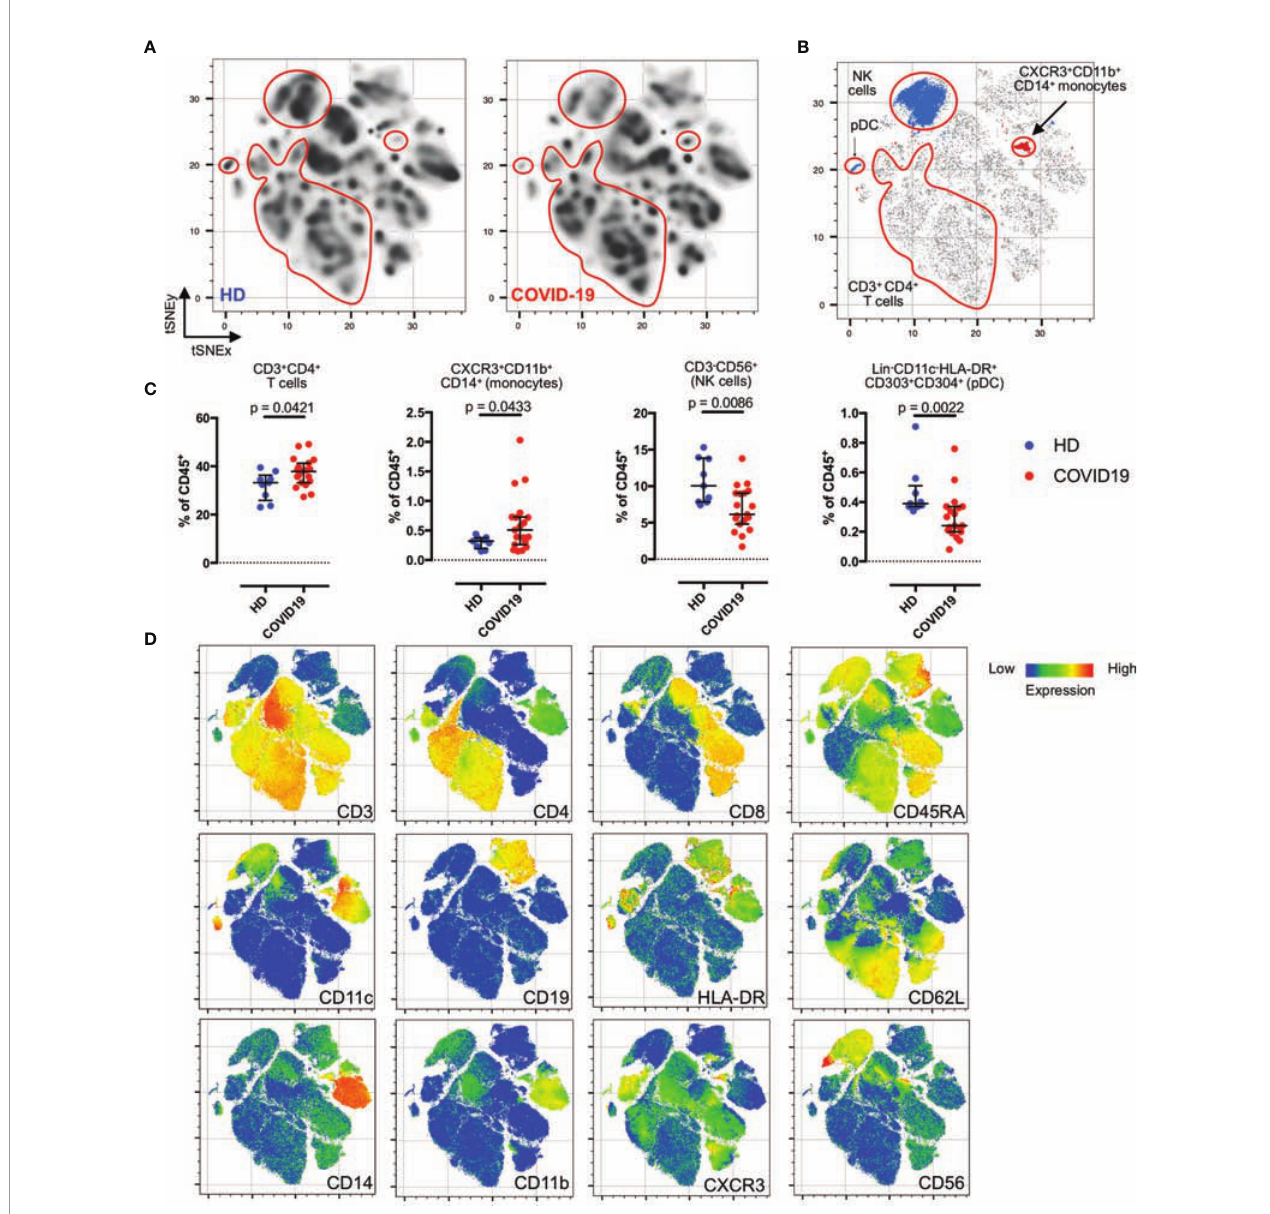
FIGURE 1 | Residual post-COVID-19 immune signatures during the convalescent phase. (A) Density plots after t-SNE dimensionality reduction demonstrate a similarity between the convalescent and healthy immunomes. Each density plot is derived from the random sampling of 50,000 single events from the concatenated mass cytometry data from 9 HD and 19 COVID-19 subjects for their respective plot. The red outlines demarcate statistically different cell clusters between COVID-19 patients and HD. (B) Total CD3 + CD4 + T cells (merged FlowSOM CD3 + CD4 + clusters), CXCR3 + CD11b + CD14 + monocytes, CD3 - CD56 + NK cells (merged FlowSOM CD3 - CD56 + clusters) and Lin - CD11c - HLA-DR + CD303 + CD304 + pDC showing statistically signi fi cant differences between COVID-19 and HD. Signi fi cantly different cell clusters are coloured blue (enriched in HD) or red (enriched in COVID-19 patients). Scatter plot of 280,000 single cell events with 10,000 per subject (n = 19, COVID-19 and n = 9, HD). (C) Comparison of FlowSOM-derived cell frequencies of CD3 + CD4 + T cells, CXCR3 + CD11b + CD14 + monocytes, CD3 - CD56 + NK cells and pDC between HD and COVID-19 convalescent patients. The FlowSOM-derived cell frequencies strongly correlated with the bivariate gated cell frequencies ( Supplemental Figure 3 ), indicating the reliability of the FlowSOM-derived cluster frequencies for statistical inferences. (D) t-SNE plots with embedded marker expression included 280,000 single cell events with 10,000 per subject (n = 19, COVID-19 and n = 9, HD). Median and interquartile range (IQR) are shown. Mann – Whitney U (two-tailed) test, p < 0.05: statistically signi fi cant. Unstimulated PBMCs were stained with COVID-19 panel (B) ( Supplemental Table 2